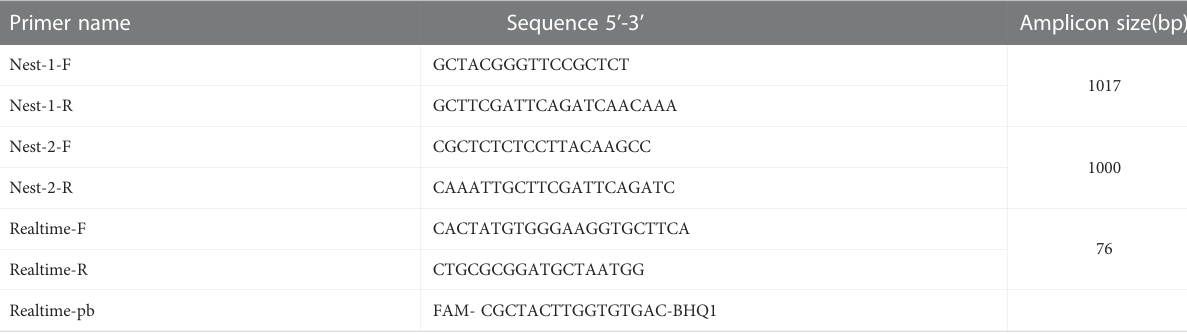
TABLE 1 Primers used for the detection of C. psittaci .